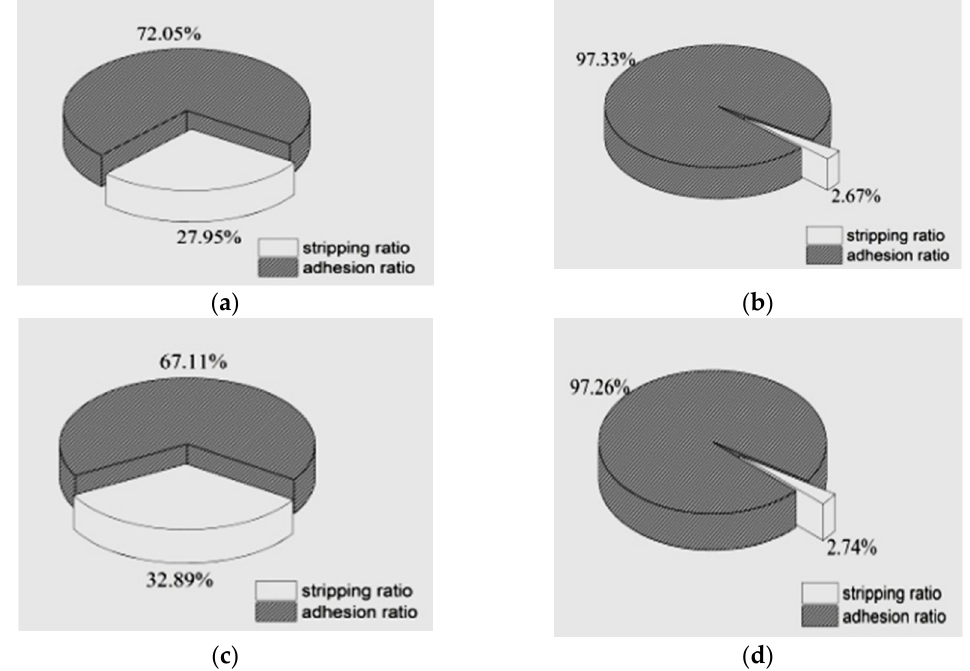
Figure 9. The adhesion and stripping ratios of granite specimen after modified stripping test: ( a ) control specimen with #90 asphalt; ( b ) treated specimen with #90 asphalt; ( c ) control specimen with #100 asphalt; and ( d ) treated specimen with #110 asphalt.